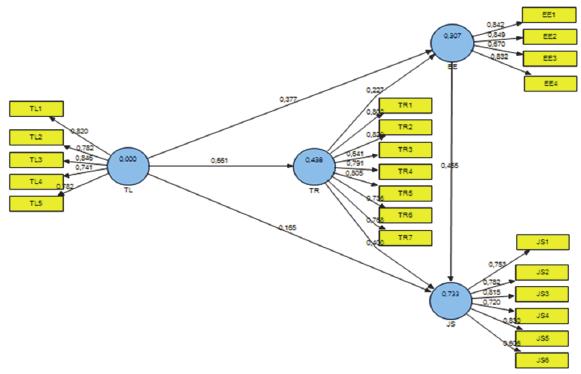
Fig. 2. Output Loading Factor